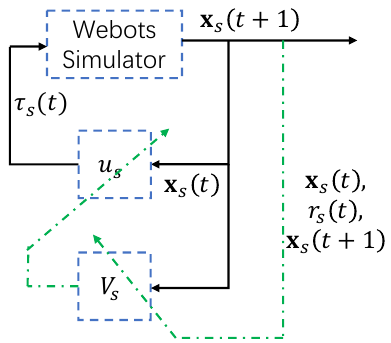
Figure 2. Learning mechanism of reinforcement